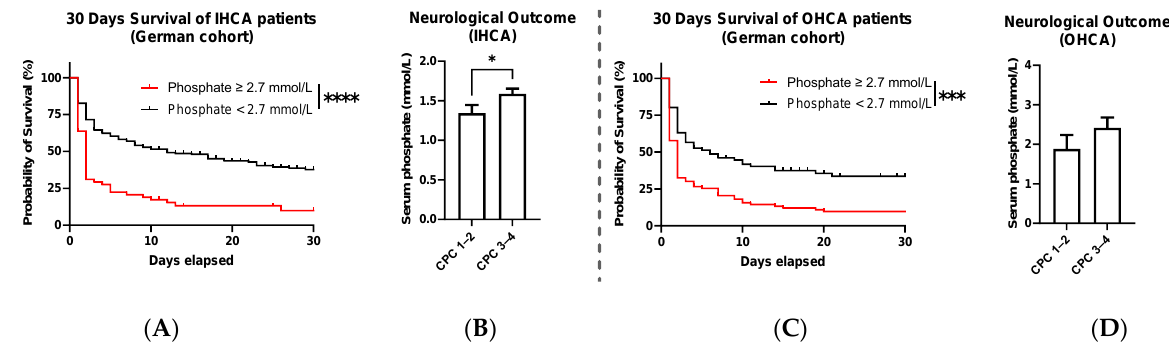
Figure 4. ( A ) Kaplan – Meier curve representing the survival of IHCA patients achieving ROSC in dependency of their initial serum phosphate >2.7 mmol/L (red) or ≤2.7 mmol/L (black) (Log -rank (Mantel – Cox) test: **** p < 0.0001). ( B ) Comparison of the average serum phosphate levels of IHCA patients dependent on the neurological outcome measured by the cerebral performance index (mean phosphate: 1.3 ± 0.1 (SEM) in CPC 1 – 2 vs. 1.6 ± 0.07 mmol/L in CPC 3 – 4, Mann – Whitney test: * p = 0.0168). ( C ) Kaplan – Meier curve representing the survival of OHCA patients achieving ROSC in dependency of their initial serum phosphate > 2.7 mmol/L (red) or ≤2.7 mmol/L (black) (Log -rank (Mantel – Cox) test: *** p = 0.0001). ( D ) Comparison of the average serum phosphate levels of OHCA patients dependent on the neurological outcome measured by the cerebral performance index (mean phosphate: 1.9 ± 0.3 (SEM) in CPC 1 – 2 vs. 2.4 ± 0.3 mmol/L in CPC 3 – 4, Mann – Whitney test: ns p = 0.1859).